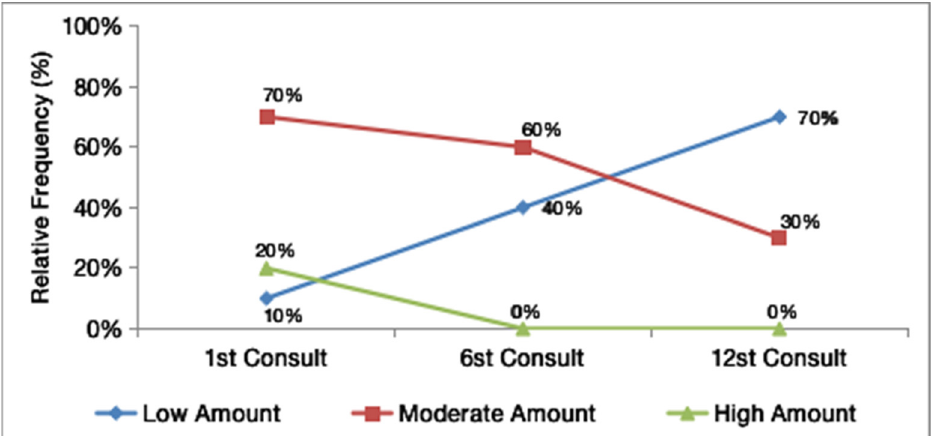
Figure 2. The evolution of the frequencies of each classification of the amount of exudate in the wound bed.